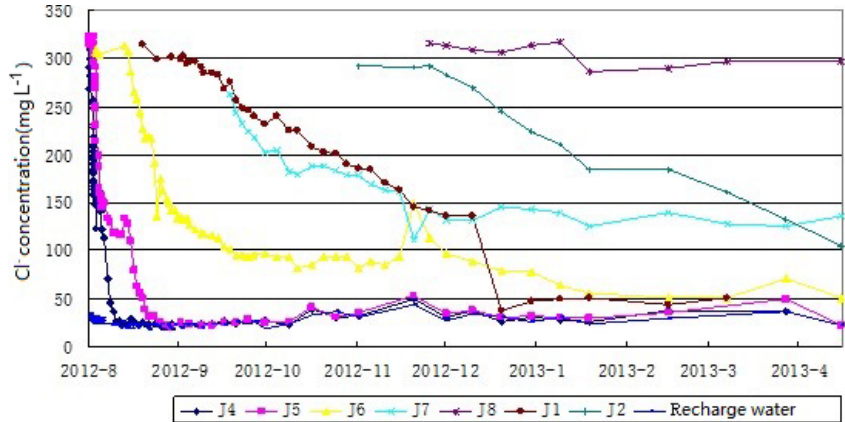
Figure 5. Land subsidence curve during rechaging.